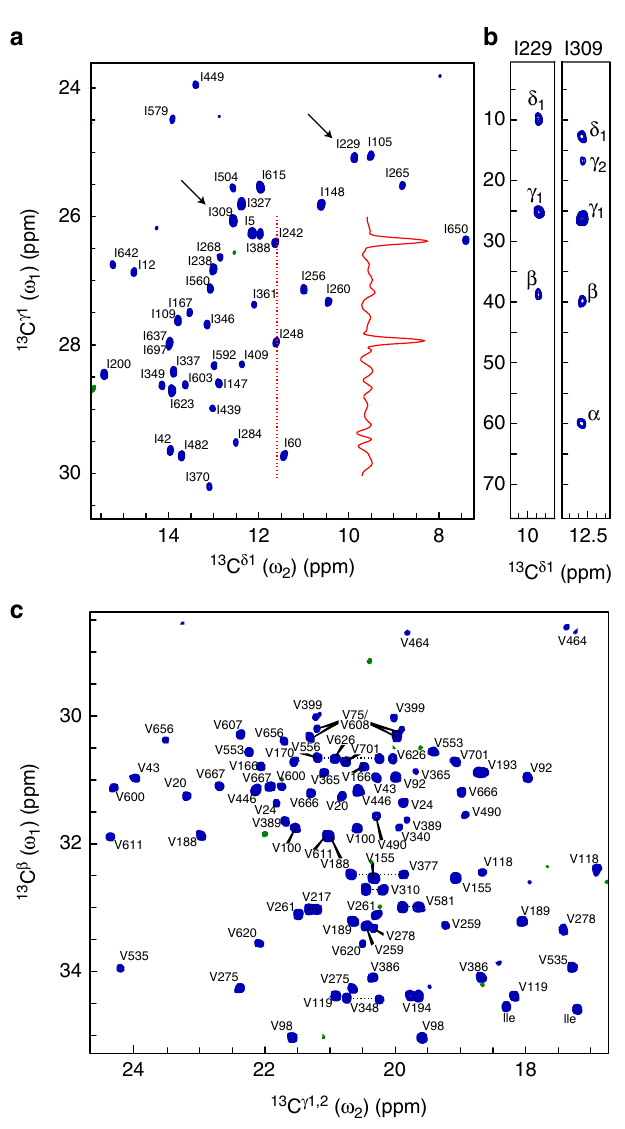
Fig. 3 13 C – 13 C side-chain correlation spectra of a large protein. a Isoleucine 13 C δ 1 – 13 C γ 1 and c valine 13 C γ – 13 C β correlation spectra of a 0.5 mM sample of the 82-kDa protein MSG. Each of the two spectra in a and c were recorded in 7.5 h at 18.8 T using a standard helium-cooled Bruker TCI